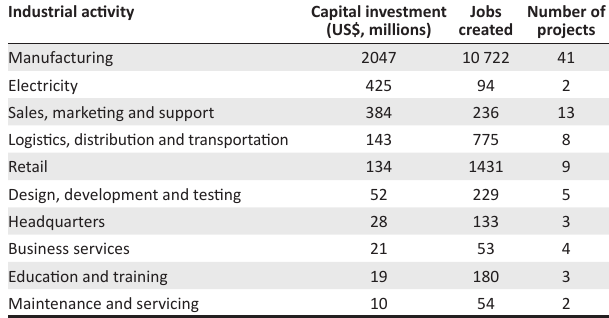
Table 2 indicates the top 10 source countries for FDI in agriculture in South Africa between 2003 and 2014. The figures indicate the dominance of the United Kingdom and the Netherlands as the leading sources of FDI in agriculture to South Africa. The United States followed by Switzerland, Australia and Japan forms a second grouping based on the amount spent by the source countries; Austria and Germany form a third grouping, with Canada, India and China making up the last of the top 10 source countries. When the number of